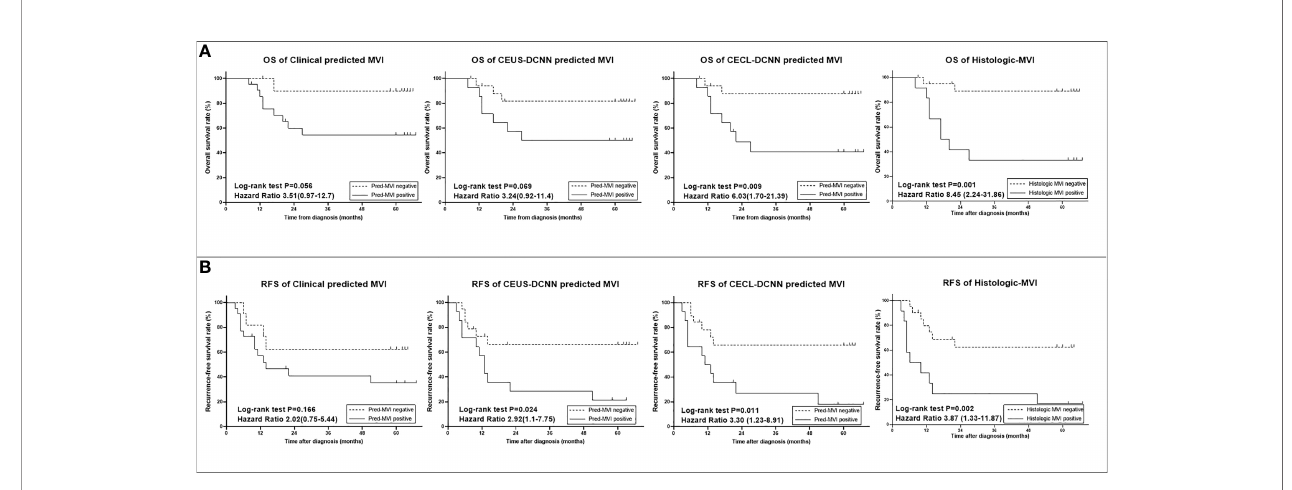
FIGURE 4 | Survival curves of histologic microvascular invasion (MVI) and predicted MVI of the three models in the test group ( n = 33). (A) Overall survival (OS) curves. (B) Recurrence-free survival (RFS) curves. Comparisons between curves were performed with the log-rank test. CEUS-DCNN: CEUS video-based deep convolution neural network model. CECL-DCNN: clinical parameter combining CEUS-based deep convolution neural network